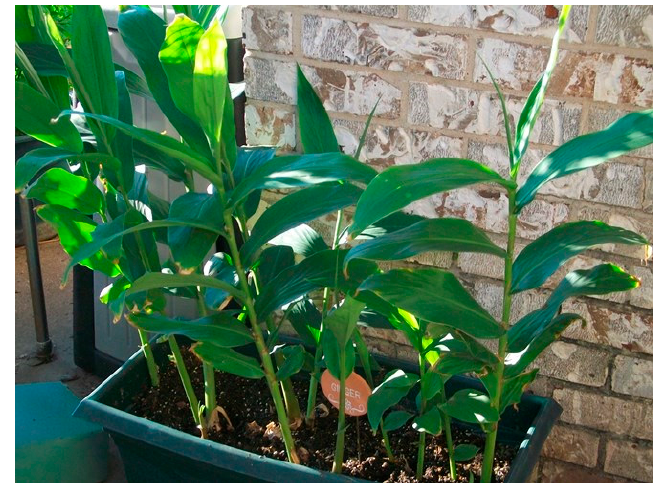
Figure 18. Zingiber officinale Rosc.